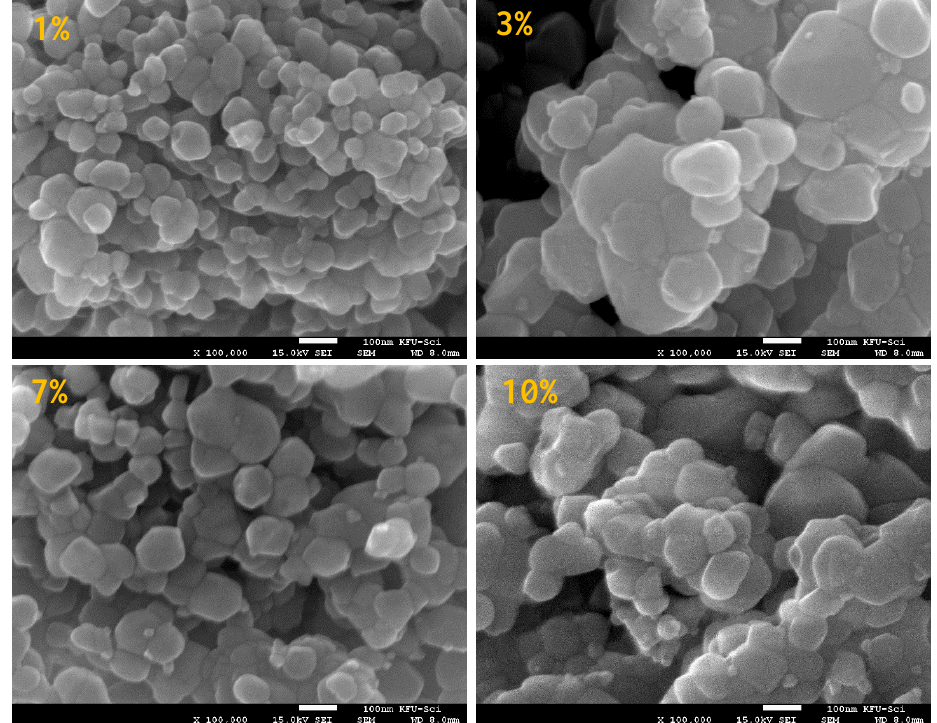
Figure 3. SEM images recorded at higher magnifications (100,000×) showing the granular morphology of ZnNiO powders at 1%, 3%, 7% and 10% doping percentages. The white colored bar-scale in the bottom of each image represents 100 nm.